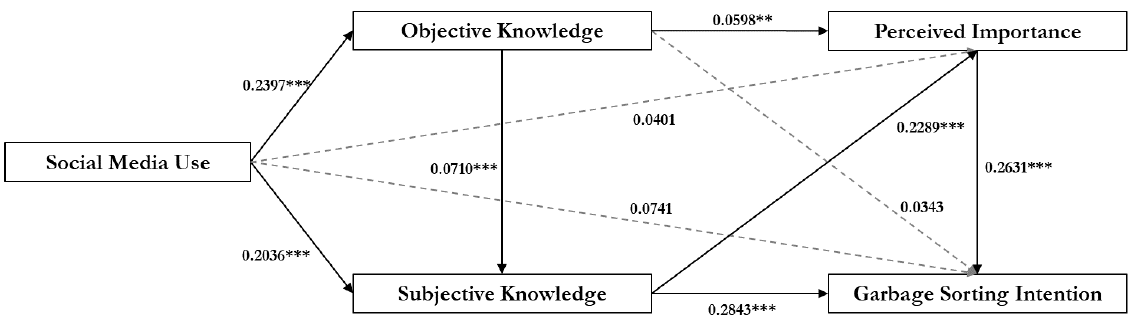
Figure 2. Sequential mediation model with coefficients. Note. ** p < 0.01, *** p < 0.001.